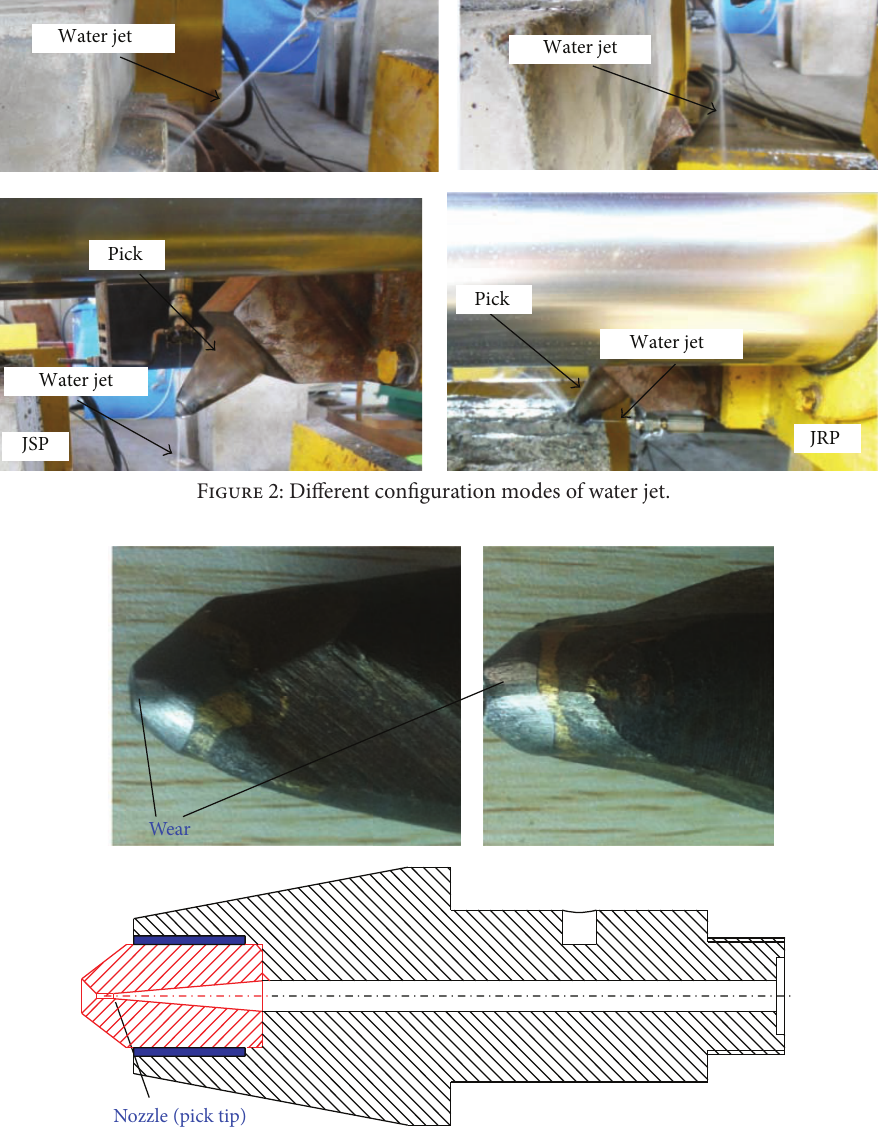
Figure 3: Wear of conical